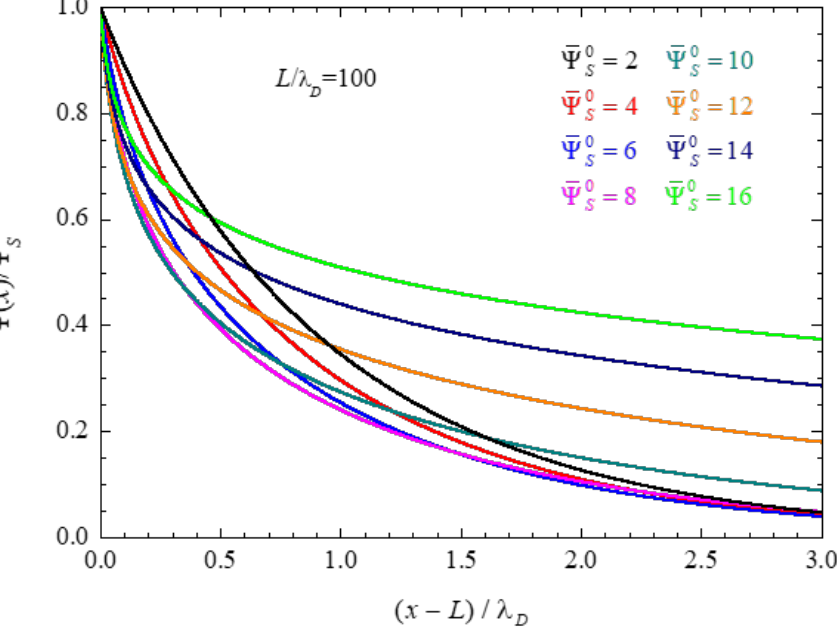
Figure 2. Numerical results for the electric potential profiles in a closed electrolytic cell calculated for L / λ D = 100 and the indicated surface potential values.